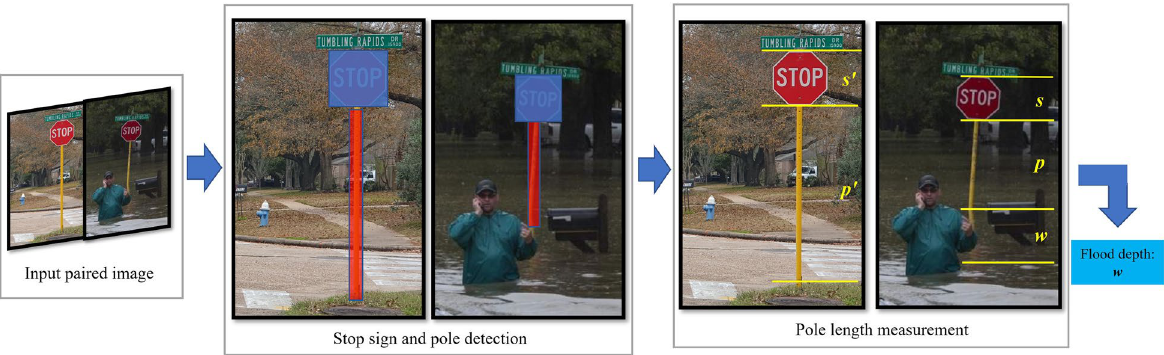
Table 2 Overview of the training and test datasets Subset Source Training set (Blupix v.2021.2)